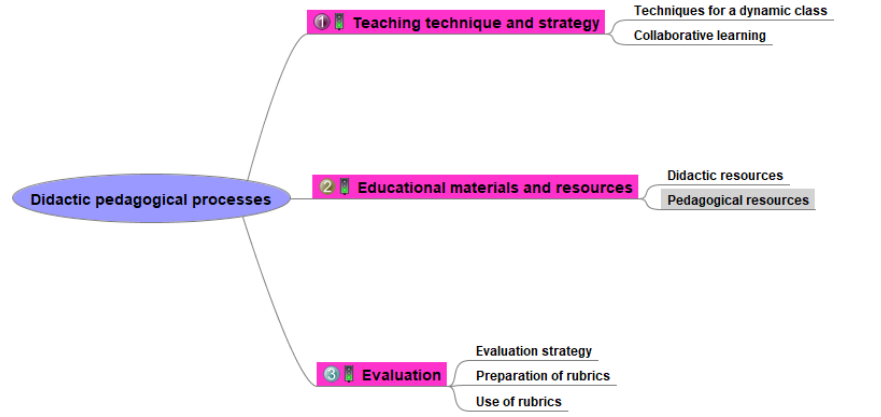
Fig. 4. Didactic pedagogical